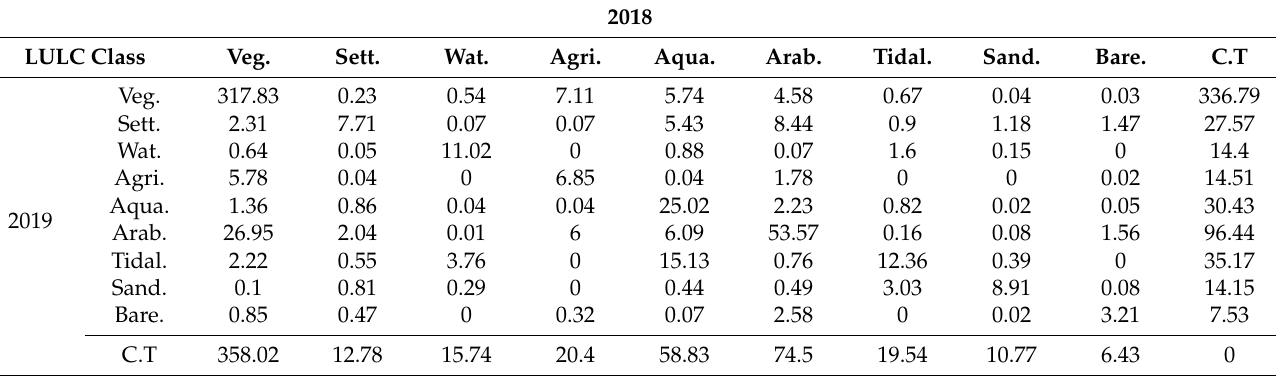
Table A4. Spatiotemporal transition of LULC, Ukhiya-Teknaf, 2018–2019 (in km 2 ), here, Veg. = vegetative, Sett. = Settlement, Wat. = Water-body, Agri. = Agricultural land, Aqua. = Aquaculture land, Arab. = Arable land, Tidal. = Tidal Mudflat, Sand. = Sandy area, Bare. = Bare land.